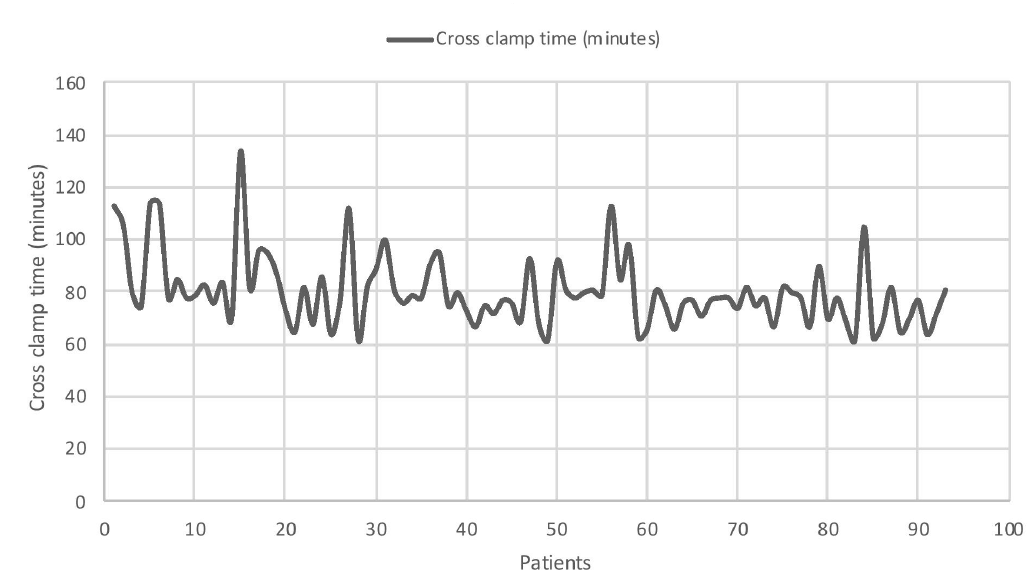
Fig. 2 - Trend of cross-clamp times over